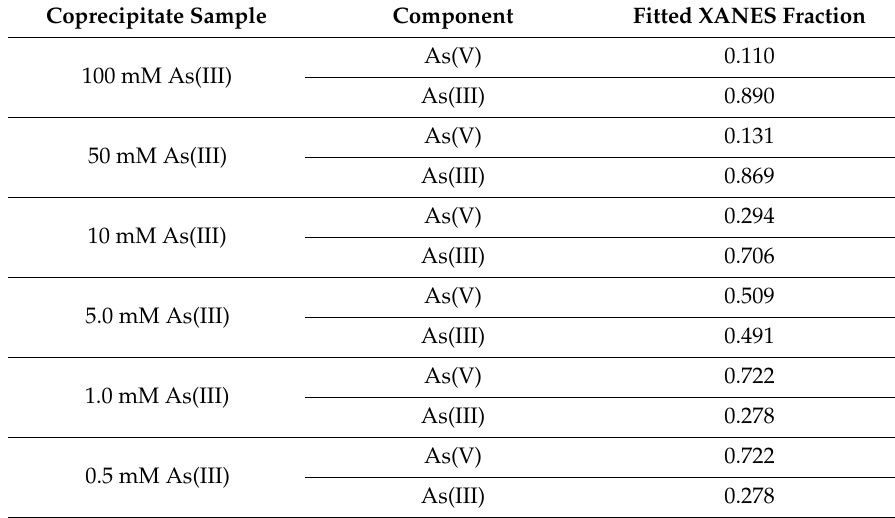
Table 3. Arsenic XANES fits and estimated fractions of coprecipitated As(III) oxidized to As(V) from XANES